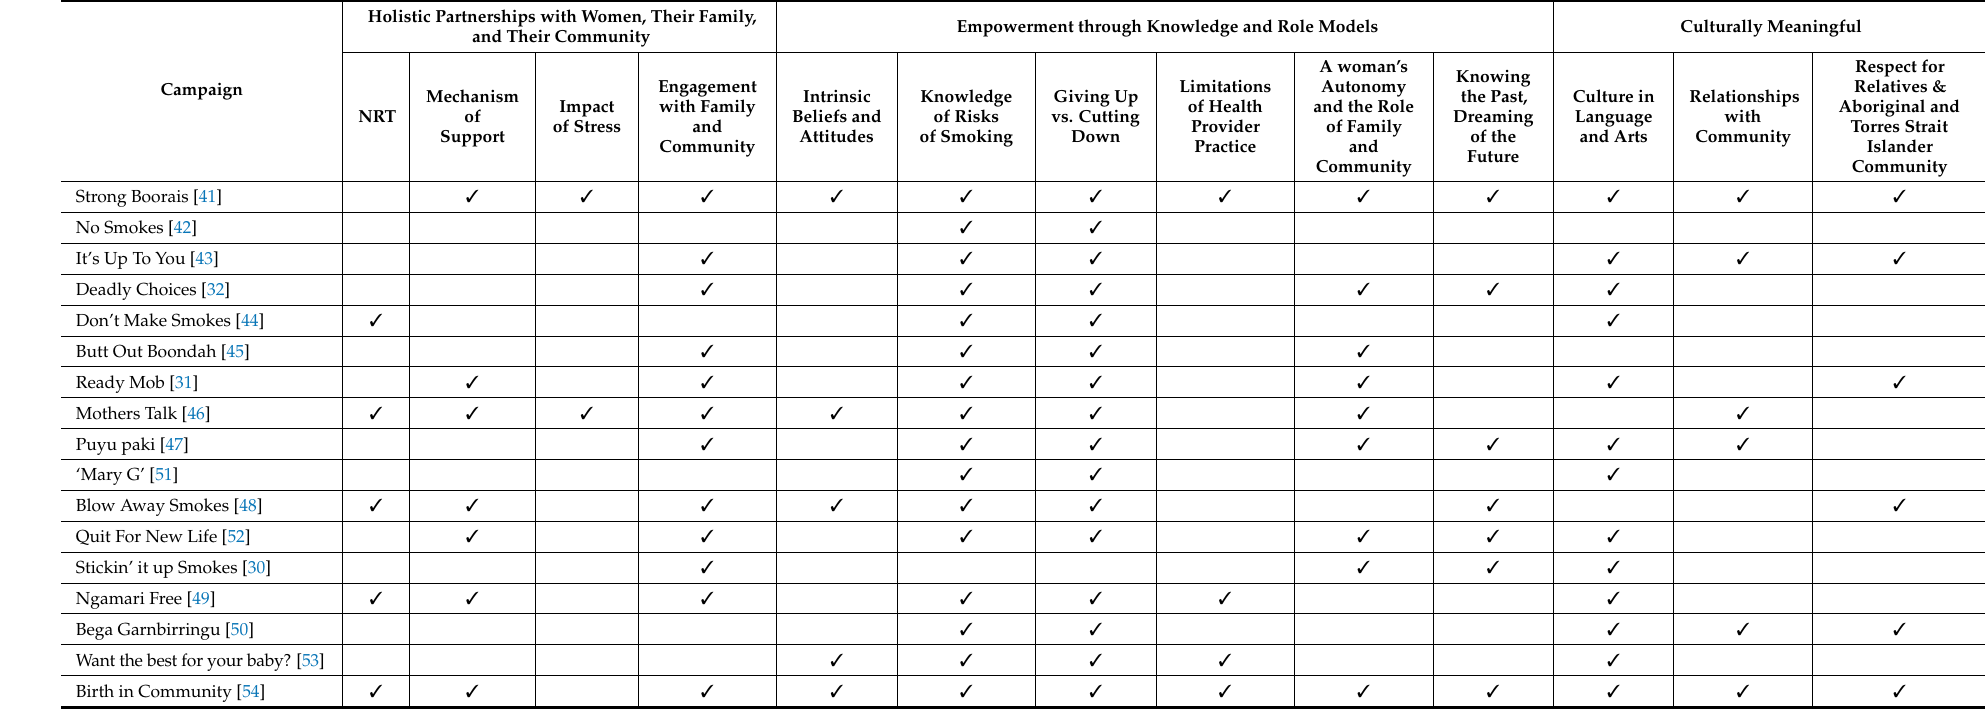
Table 6. Alignment of messages within the health promotion materials with the peer reviewed literature themes. Holistic Partnerships with Women, Their Family, and Their Community Empowerment through Knowledge and Role Models Culturally Meaningful Mechanism of Impact of